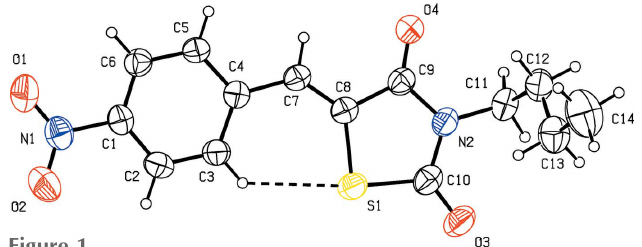
Figure 1 A view of the molecular structure of the title compound, with atom labelling. Displacement ellipsoids are drawn at the 30% probability level. The intramolecular C—H (cid:3)(cid:3)(cid:3) S interaction (see Table 1) is shown as a dashed